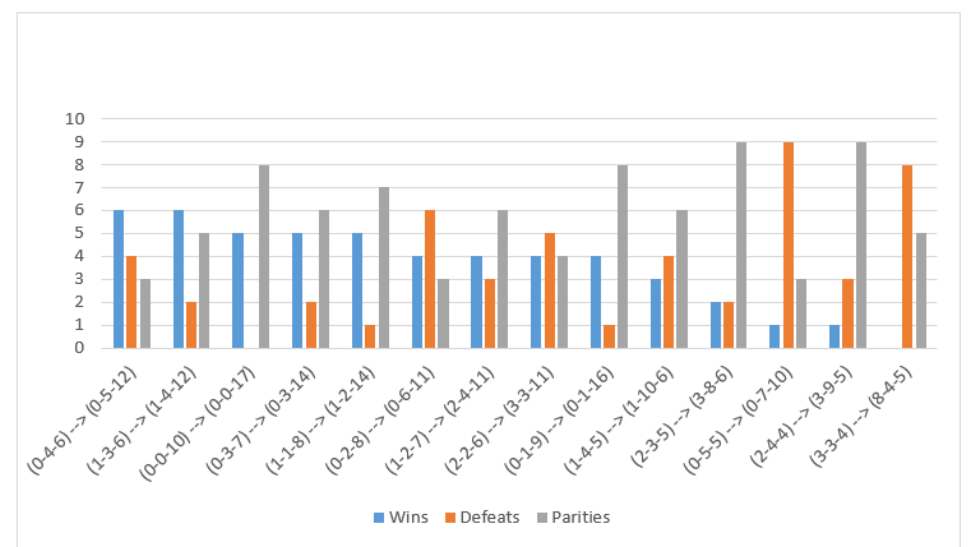
Figure 5. Graphical representation of the simulation result with heterogeneous fields and